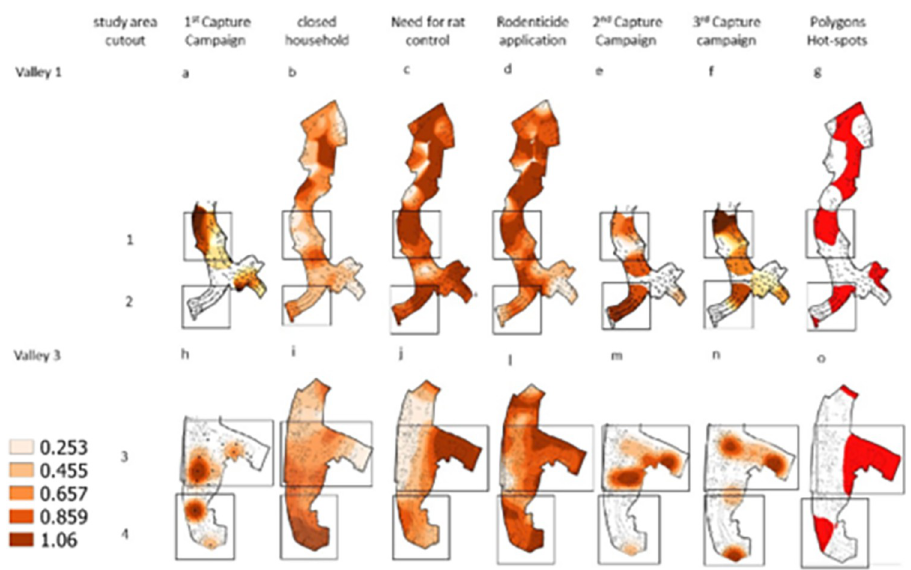
Fig 3. Valley 1 and Valley 3 respectively: a and h) kernel Density Estimation (KDE) of the 1st rodent capture campaign, b and i) Kernel Ratio (KR) of closed households by the total of households, c and j) KR of households that need rodenticide control by evaluated households, d and l) KR of rodenticide application in households by households that need for rodent control, e and m) KDE of the 2nd rodent capture campaign, f and n) KDE of the 3rd rodent capture campaign, g and o) Polygons of hot areas of households that need for rodent control identified by agents of the Zoonoses Control Center of Salvador, Bahia, Brazil. In valley 1 and valley 3 the upper part of the area was not shown in some figures due to the absence of rodent capture campaign at this